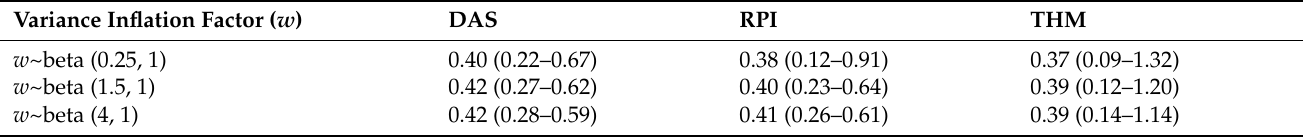
Table 3. Estimated effects and 95% credibility intervals of the effectiveness of pneumococcal polysaccharide vaccine (PPV23) vaccination in preventing invasive pneumococcal disease (IPD) in elderly